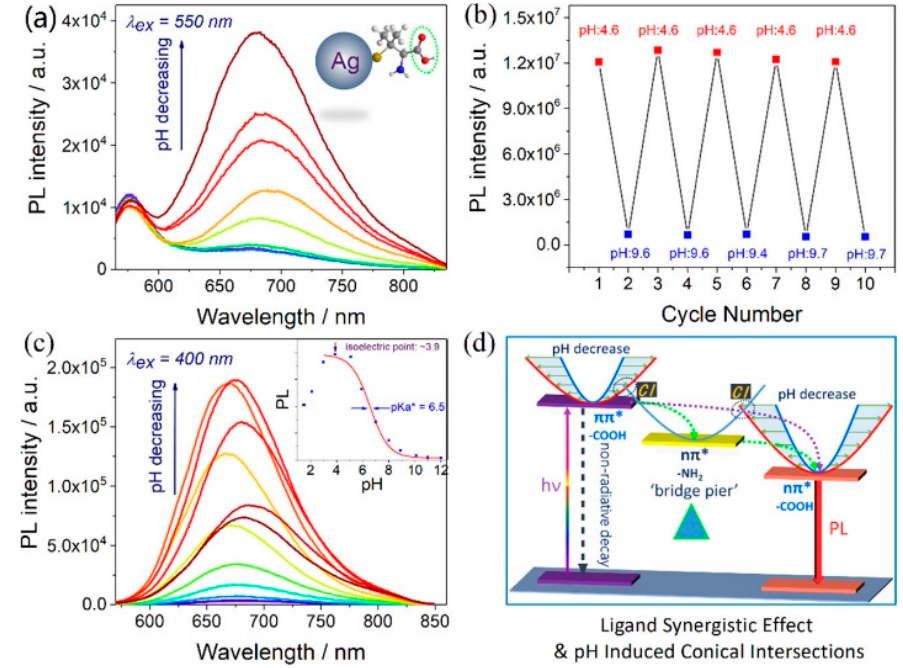
Figure 12. ( a ) Photoluminescence spectra of as-synthesized DPA-AgNCs in different pH conditions. 505. nm. ( b ) PL intensity of DPA-AgNCs upon cyclic switching of the pH between 4.6 and 9.7. ( c ) PL spectra and PL intensity (inset) of DPA-AgNCs with changing pH values. PL spectra were excited at 400 nm; pH value over the range 1.5 − 12. ( d ) Schematic illustration of the ligand synergistic effect and pH-induced conical intersections. Reprinted with permission from Ref. [87]. Copyright (2019) American Chemical Society.